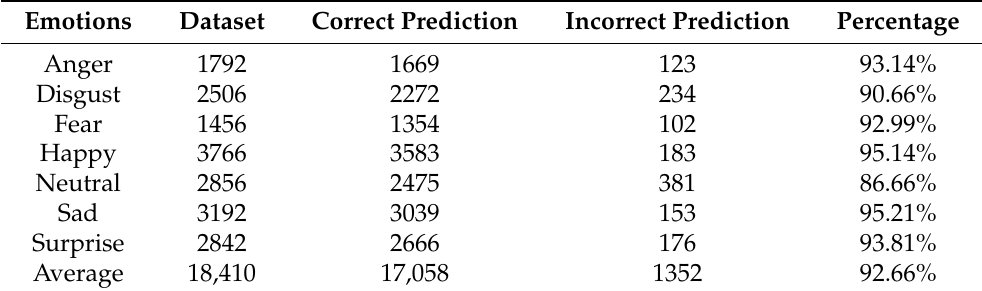
Figure 6. Confusion matrices after 100 epochs, ( a ) Test Model 1, and ( b ) Test Model 2. Table 14. Test result with prediction detail of the proposed model after 100 epochs.